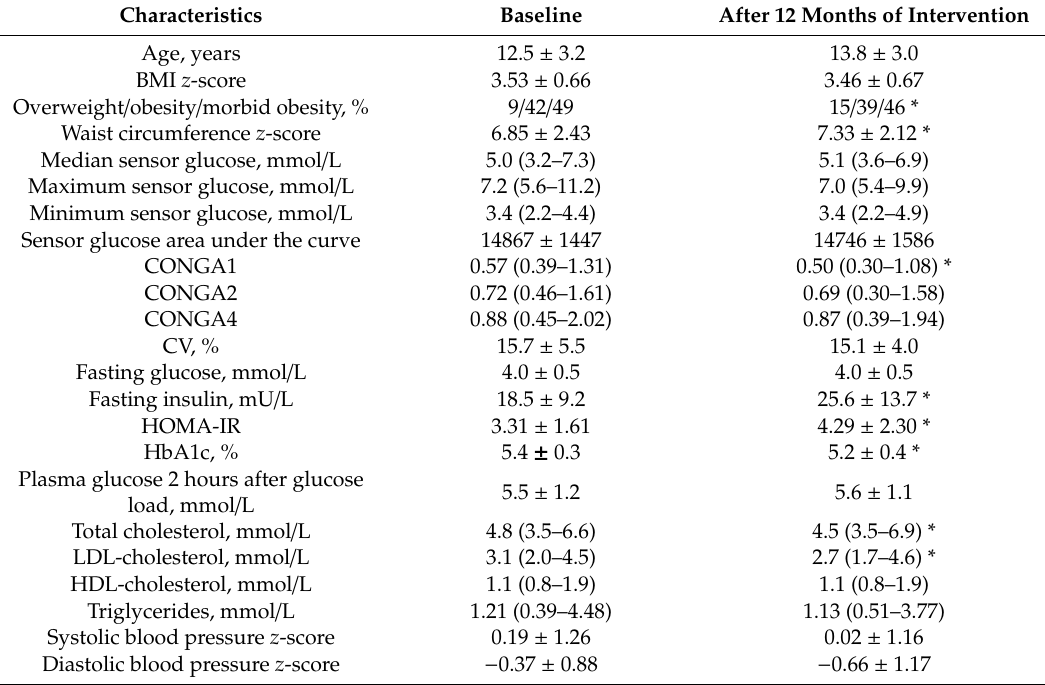
Table 1. Characteristics of the study participants at baseline and after 12 months of lifestyle